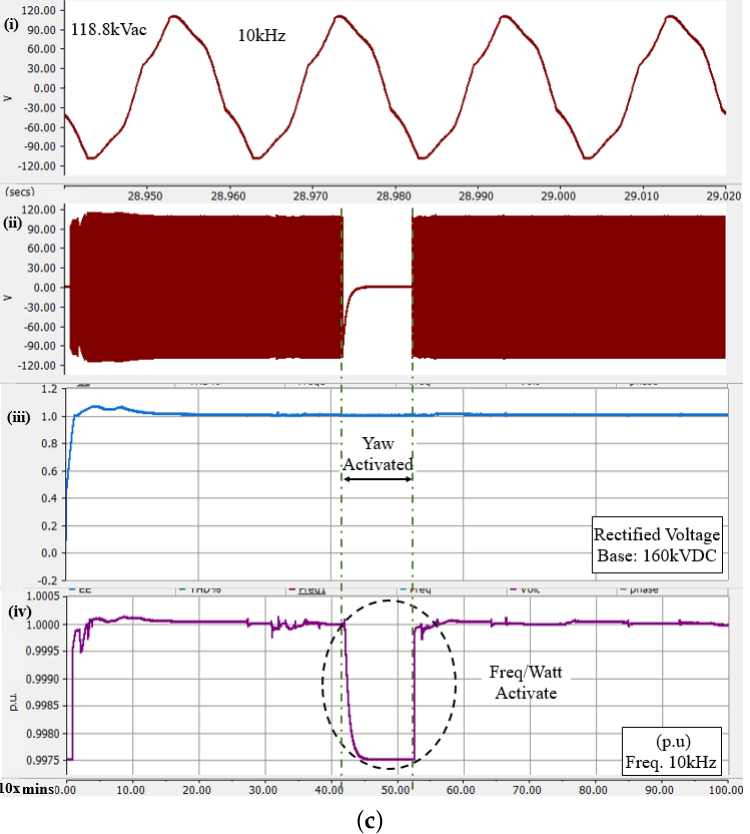
Figure 9. ( a ) pitching-PMSG-ZSI performances; (i) K p and K i adaptive responses; (ii) AC voltage transient generated from ZSI’s output, ordered 53 kV AC ; (iii) voltage transient comparison against voltage ride-through criterion, ZSI output; (iv) ramp rate of voltage and current transients during PMSG start-up; ( b ) ZSI operations; (i) instantaneous ZSI output voltage; (ii) zoomed in ZSI output voltage transient; (iii) boost voltage transient after Z-network; (iv) capacitor’s voltage (kV) and inductor’s current ( kA ), Z-network; ( c ) OVC-Rect operations; (i) instantaneous LCL-filtered AC voltage at secondary-side of H-XFMR; (ii) AC-link voltage (single-phase), kV ab ( RMS ) ; (iii) rectified DC voltage at HVDC transmission, p.u.; (iv) frequency response profile at secondary-side of